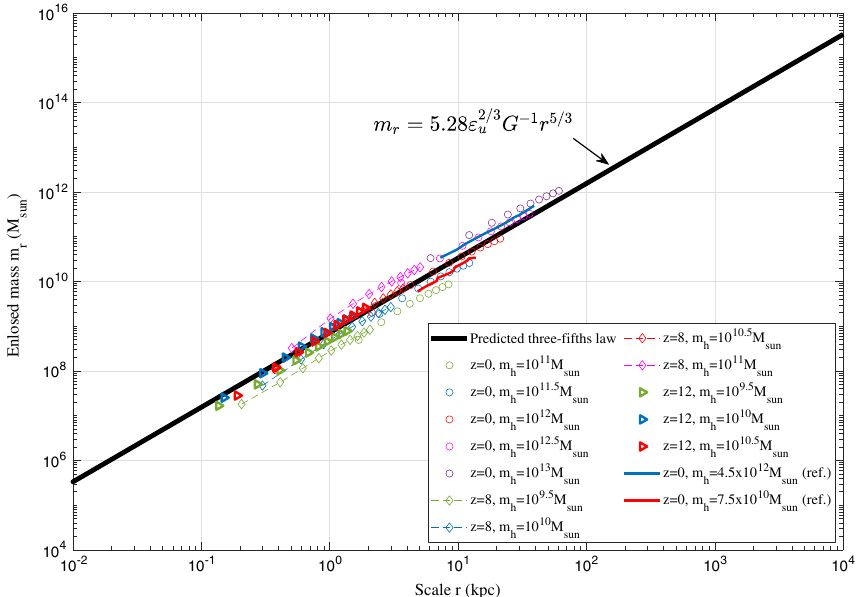
Figure 5. The variation of enclosed mass m r with scale r at different redshift from Illustris simulation. For all haloes with a given mass m h , the average scale radius r s is calculated. The average enclosed mass m r is computed 0.1 r 0.1 r for different scale r from r s to r = r s with an increment of s . Solid blue and red lines are results from = Ref. 55 . Both results confirm the predicted five-thirds law in Eq.